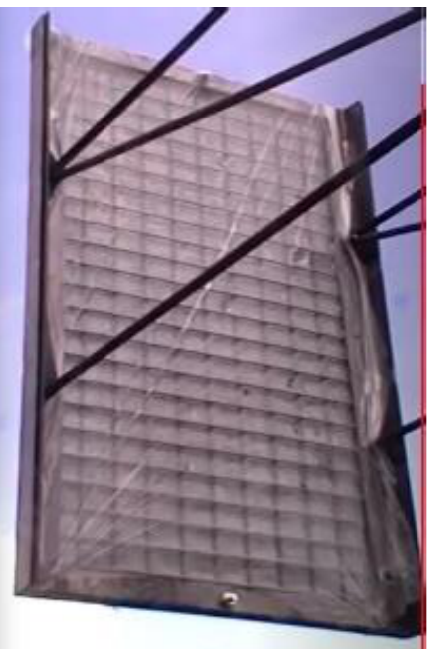
Figure 3. The image of plastic sheet and its holder used in the study. A low wind speed of less than 4.5 m/s over a fuel bed decreases the ignition time